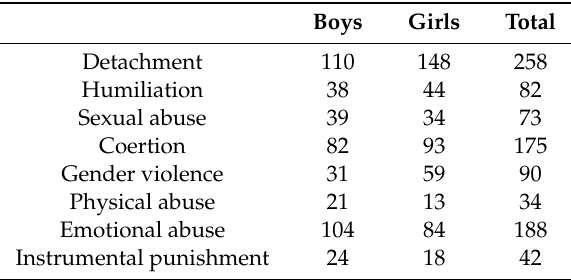
Table 1. Identification of victims of dating violence.